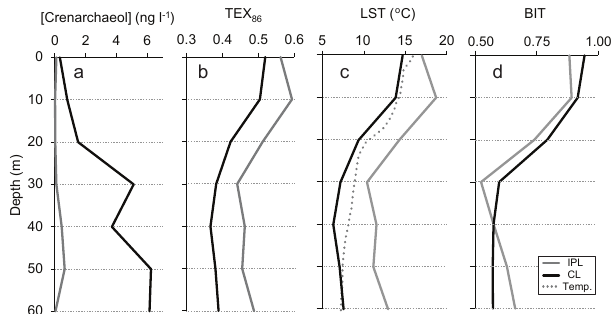
Sun11; Table 6) follow the rationale of the MBT index and CBT ratio, to be directly related to the biophysical bient temperature and pH (cf. Weijers et al., 2007a).